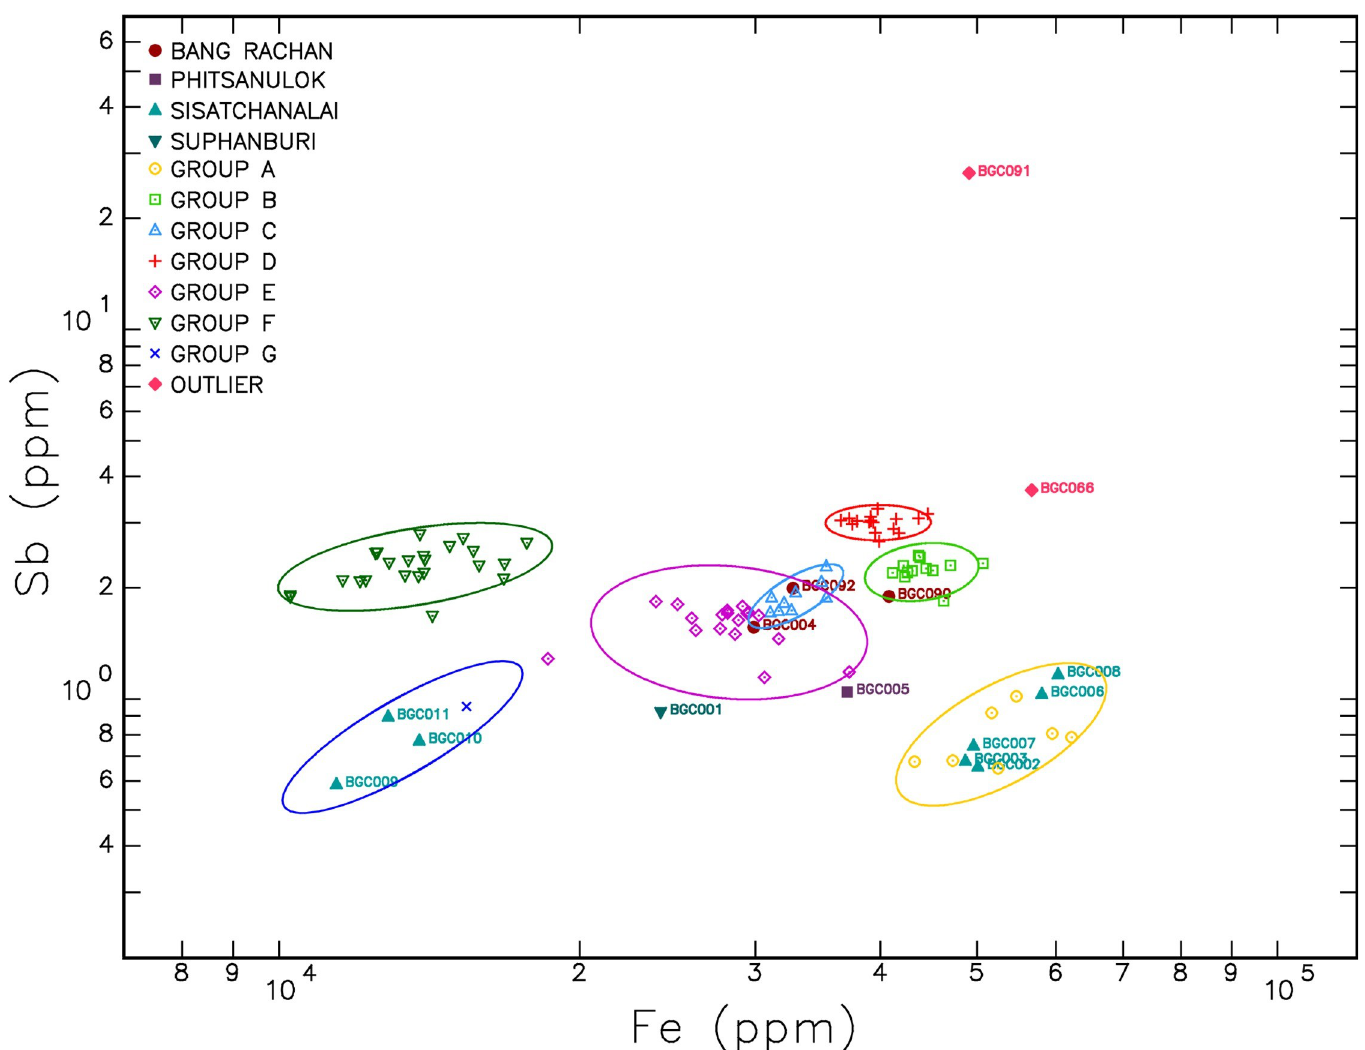
Fig 7. Bivariate log-log plot of antimony and iron concentrations classified by cluster analysis compositional groups.